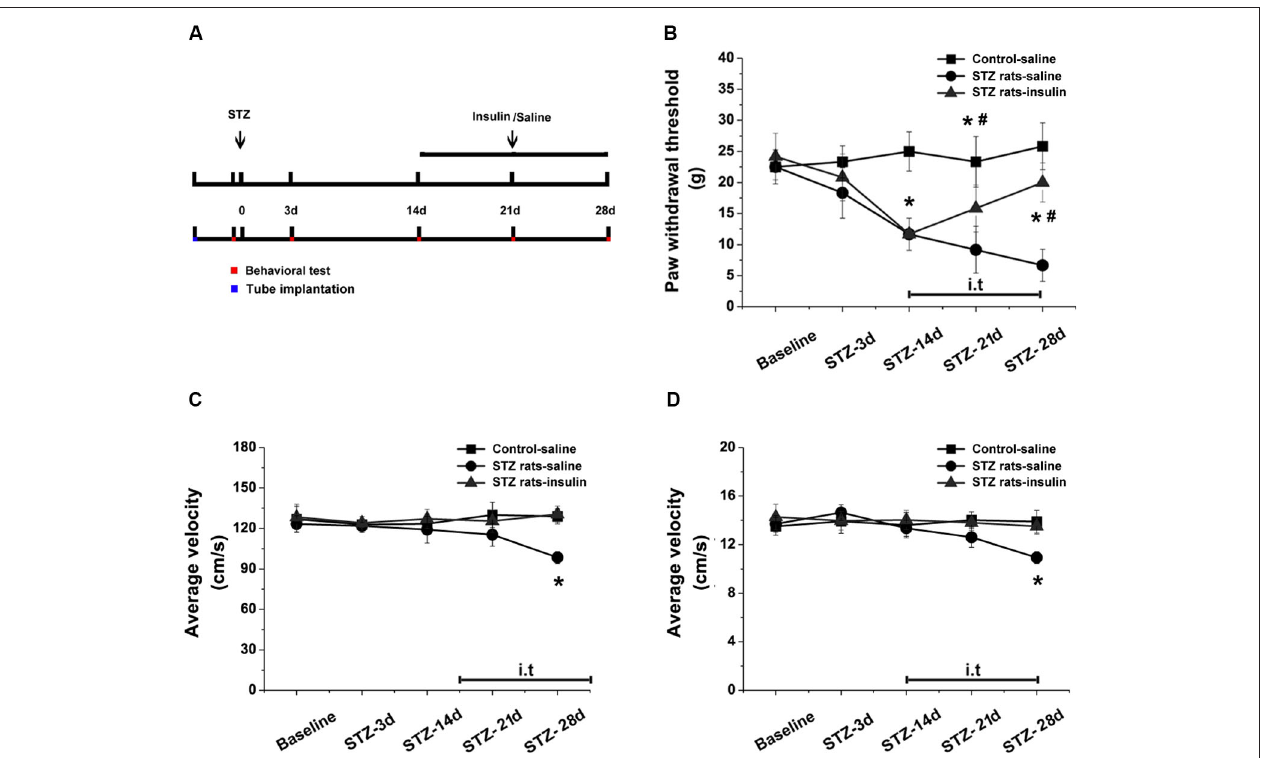
(C) , and average velocity, (D) , in the open field test) in diabetic rats after 14 days of administration. Mean ± SD, n = 6 rats in each group. * P < 0.05, comparing the STZ rats-insulin group with the STZ rats-saline group at corresponding time points. # P < 0.05, comparing the STZ rats-insulin group with the control-saline group at corresponding time